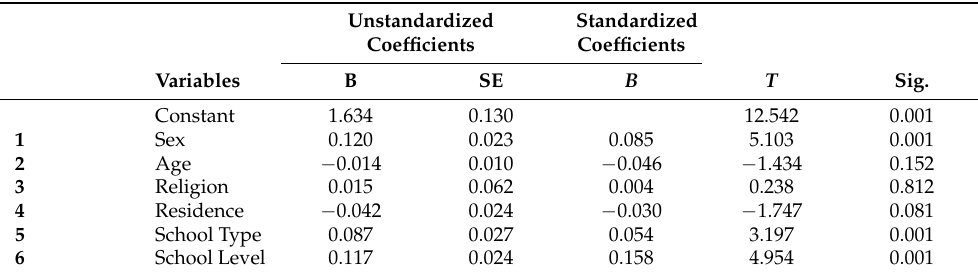
Table 5. Linear regression analysis of demographic factors (independent variables) and body weight status (dependent